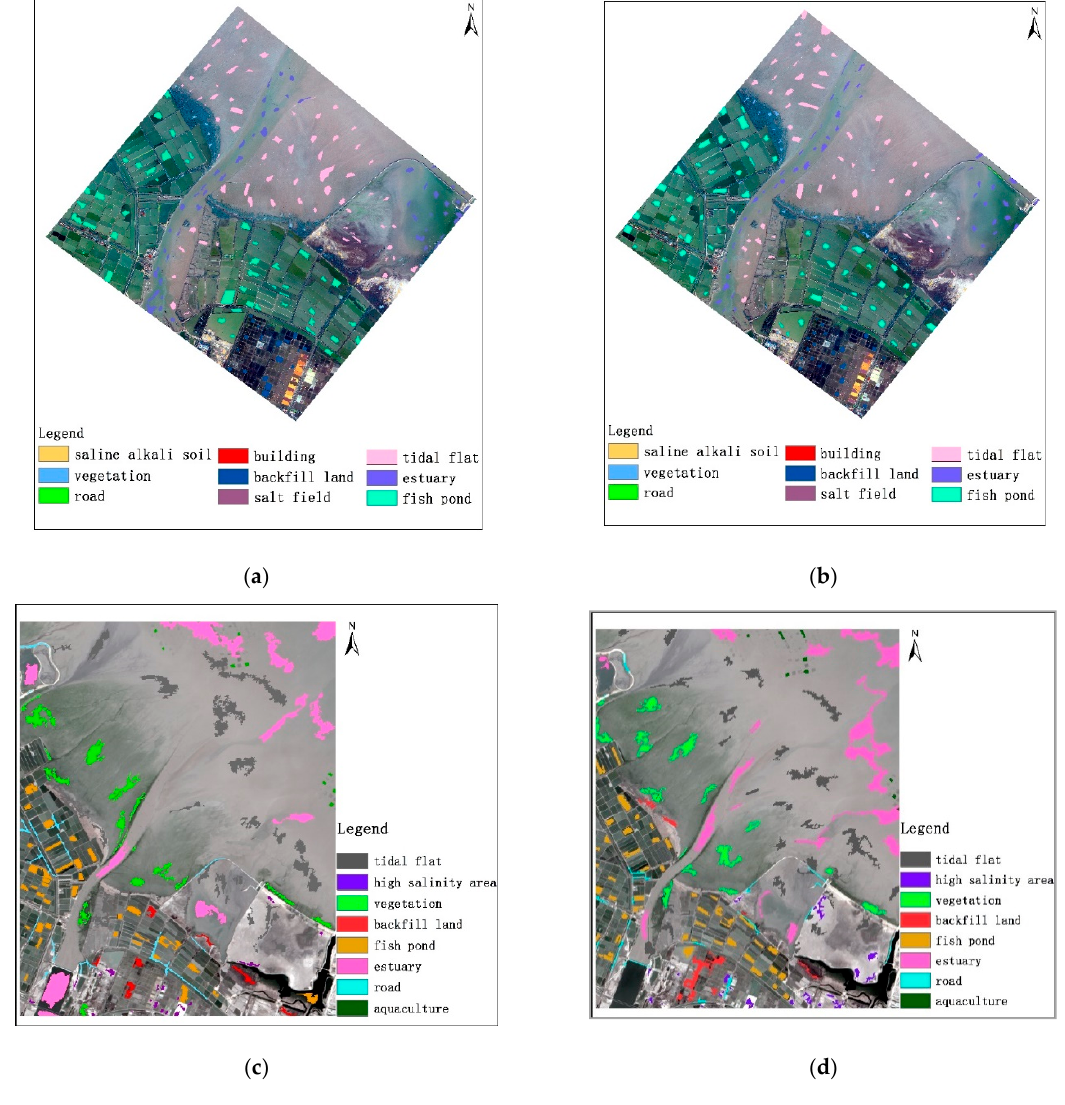
Figure 2. Worldview-2 and landsat-8 training sample and verification sample distribution. ( a ) Worldview-2 training sample; ( b ) Worldview-2 verification sample; ( c ) Landsat-8 training sample; and ( d ) Landsat-8 verification sample.